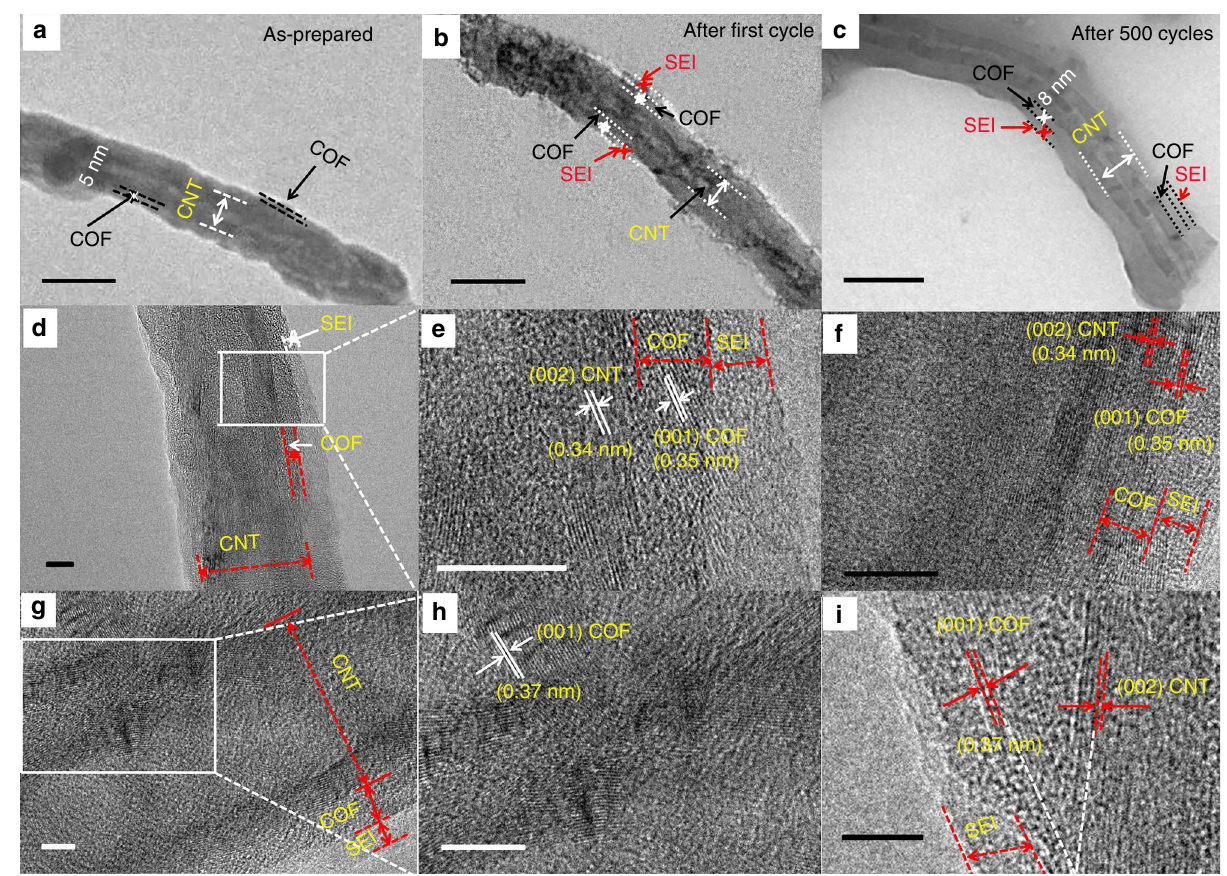
Fig. 6 Morphology variations of COF@CNTs anode during cycling. TEM images of COF@CNTs: a as-prepared, b after the fi rst cycle, and c after 500 cycles. Scale bar, 100nm. d – f HRTEM images of COF@CNTs after the fi rst cycle. Scale bar, 10nm. g – i HRTEM images of COF@CNTs after 500 cycles. Scale bar,